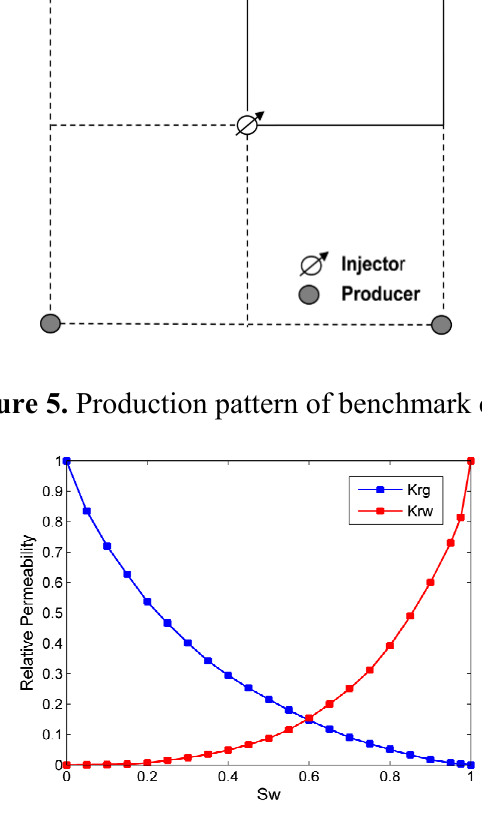
Figure 6. Gas-water relative permeability curve [45]. Table 1. Reservoir and aqueous parameters for benchmark